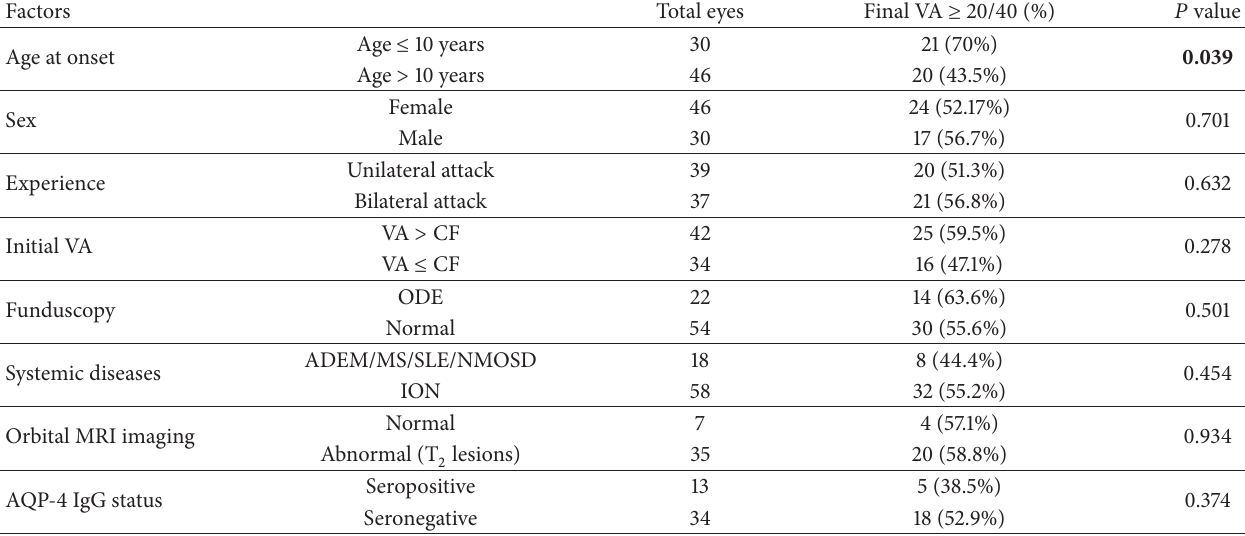
Table 3: Factors for visual outcomes in Chinese children with optic neuritis.